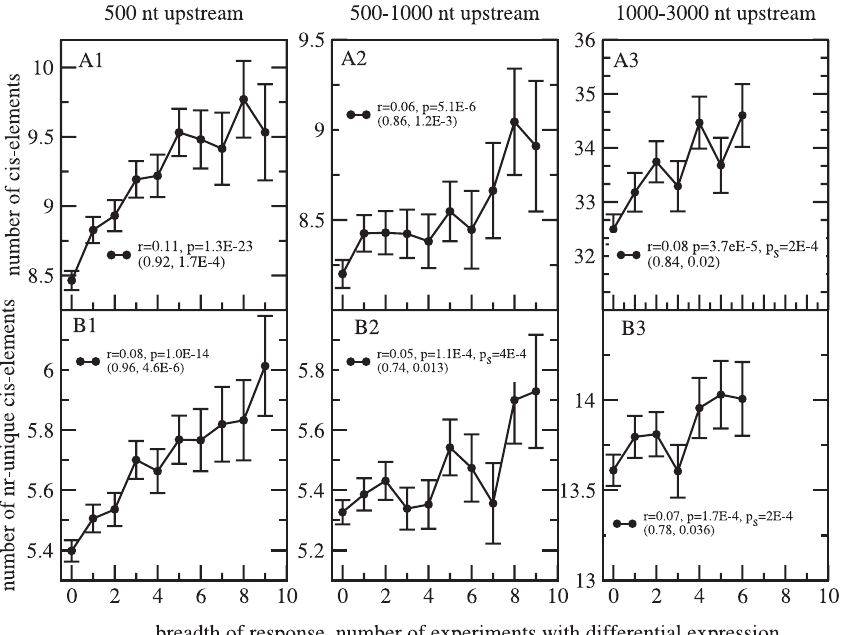
Figure 2. Correlation of the Number of cis -Regulatory Elements in Gene Upstream Promoter Regions of Different Length and Position Relative to the Transcription Start Site with the Breadth of Differential Gene Expression Response The upper row (A1–A3) shows data for all cis -elements including counts for multiple occurrences of cis -elements. In the lower row (B1–B3), only unique cis -element counts (see Methods) have been used. Genes were only included if their associated intergenic upstream region was large enough to fully contain the considered upstream interval, i.e., no overlap of preceding genes and the considered promoter segment was allowed. Shown are the mean values and the SEM. Correlation coefficients, r , and associated p -values are given for all raw data pairs (individual genes and associated motif counts) and, in parentheses, for the mean values as they are plotted in the graph. If the shuffled p -value, p S , was not zero, it is reported as well (see Methods). Mean cis -element counts were only plotted if at least 100 genes were detected at the particular breadth of response. Note: With increasing distance of the considered promoter region from the transcription start site, fewer genes were considered as intergenic upstream regions were frequently not large enough (respective gene counts were A1, B1 ¼ 8,597; A2, B2 ¼ 6,537; A3, B3 ¼ 2,737).